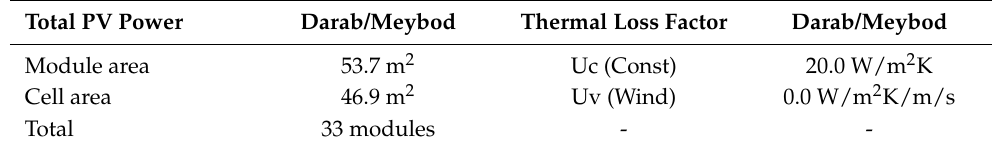
Table 6. PV array characteristics and array losses for two studied